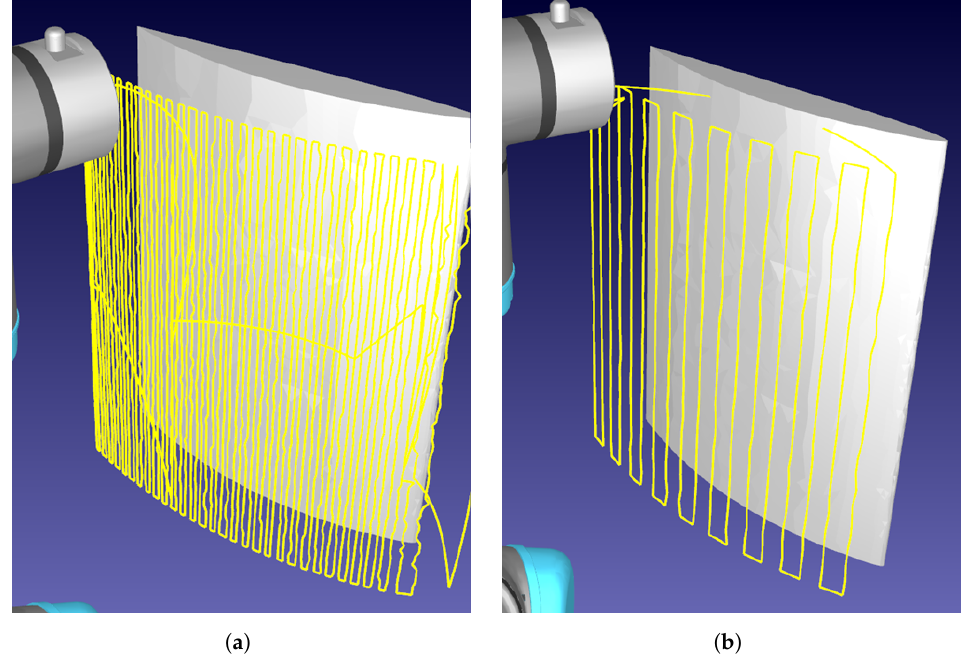
Figure 4. Demonstration of rasterizing a curved aerofoil component. The robotic path is traced in yellow, demonstrating the raster-like path obtained. ( a ) Sampling distance: 3 mm. ( b ) Sampling distance: 10